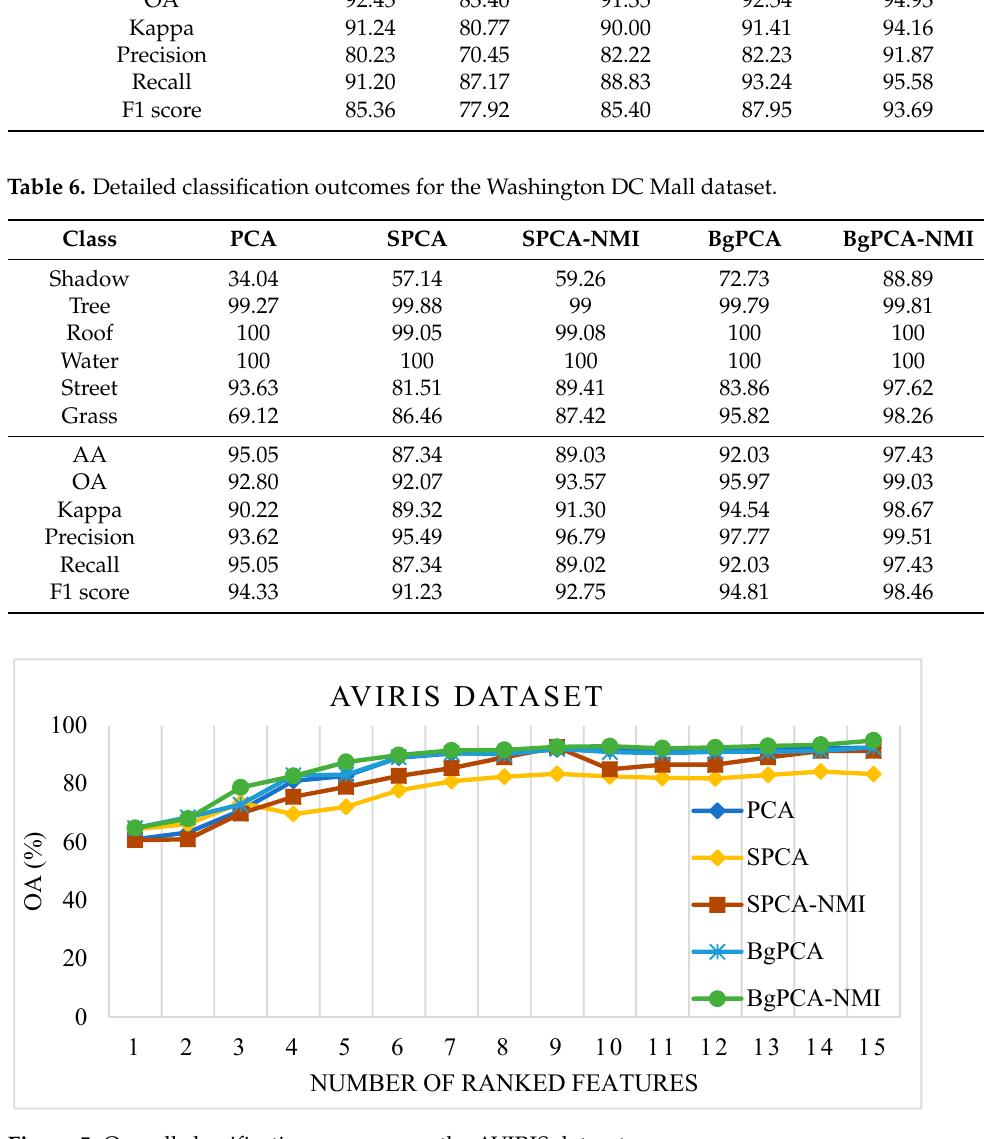
Table 4. Parameter tuning using 10-fold cross-validation.